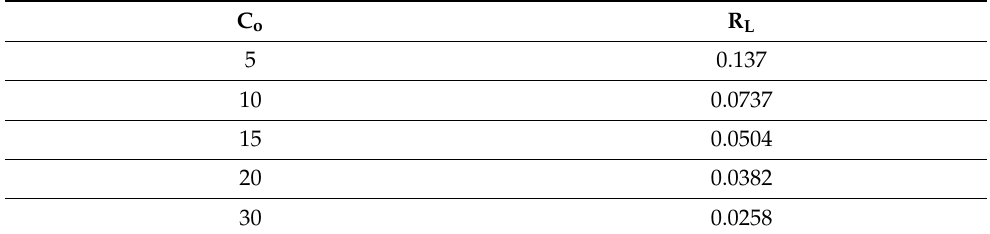
Table 1. R L values for different initial MB molecules concentrations. C